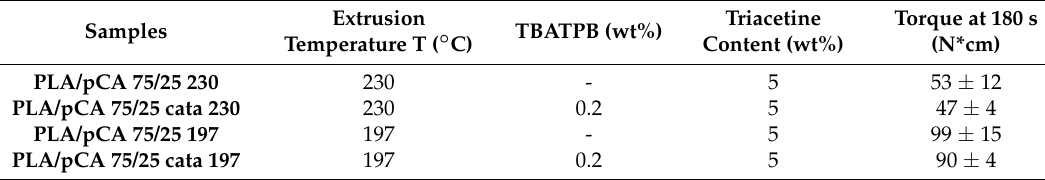
Table 1. Polylactide/triacetine plasticized cellulose acetate (PLA/pCA) blends prepared at 230 ◦ C and 197 ◦ C and with triacetine and tetrabutylammonium tetra-phenylborate (TBATPB). N*cm = N · cm. “cata” indicate the trials where TBATPB was used as